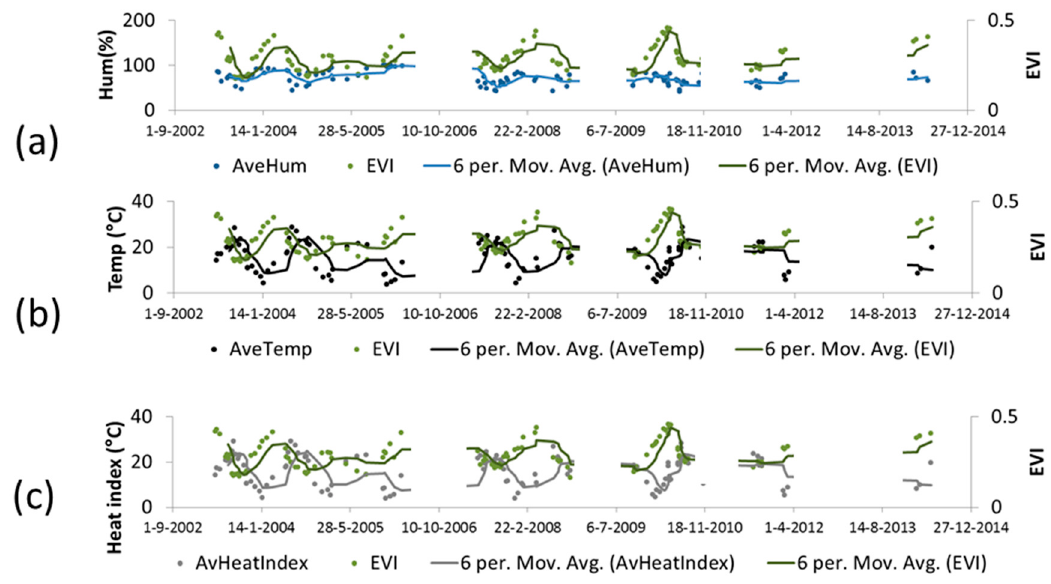
Figure 4. Inter-annual variability in EVI between 2002 and 2014 and ( a ) RH (%), ( b ) T (°C), and ( c ) HI (°C). Table 4. Correlation between EVI for each land-cover type and weather parameters. Land-cover types: dense cork oak woodlands with understorey (DCoW), dense cork oak woodlands without understorey (DCoWt), sparse cork oak woodlands with understorey (SCoW), sparse cork oak woodlands without understorey (SCoWt), and grasslands